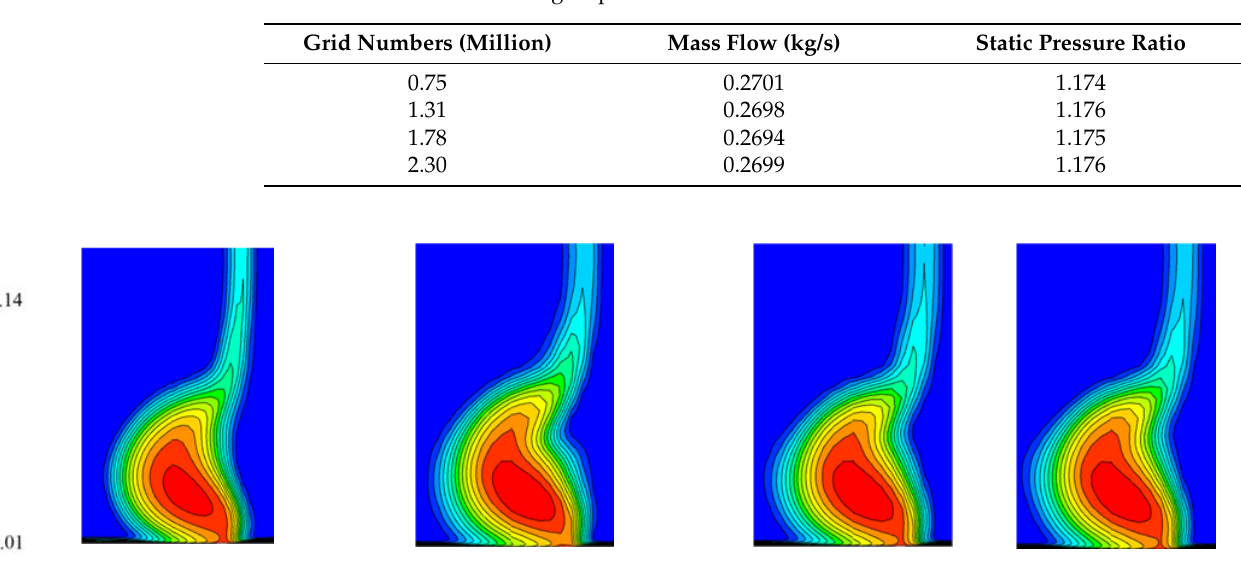
Table 2. Results for different grid points.